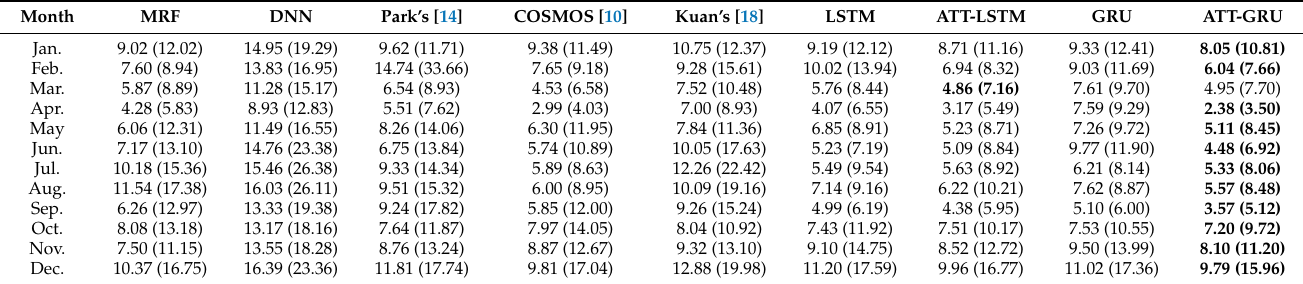
Table 9. MAPE (CVRMSE) comparison by months for Building 3.